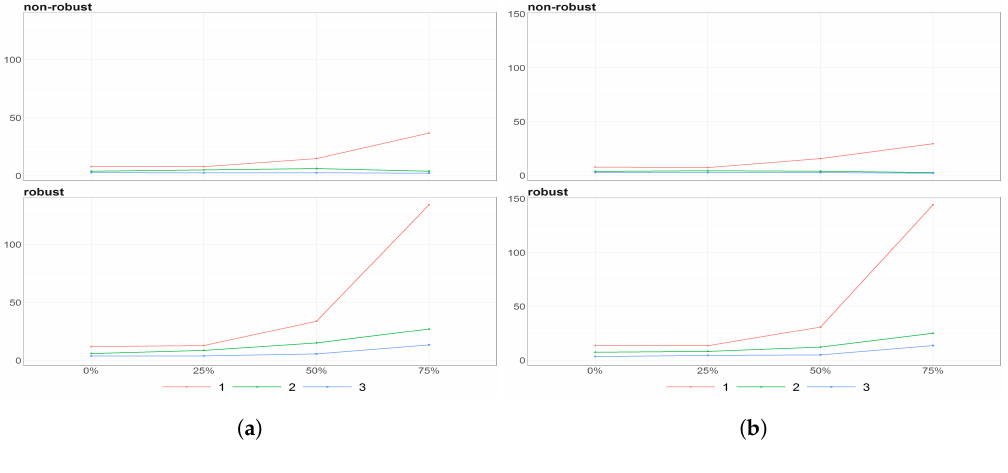
Figure 12. The eigenvalues obtained using PPCA for Females ( a ) and Males ( b ) of Life Expectancy at Birth data for different percentages of maximal missing entries in rows (x axis). Colours of lines corresponds to different eigenvalues, first (light brown), second (dark blue) and third (dark brown) highest. Every subfigure is divided into two subplots corresponding to robust estimation of standard divinations (upper plot) and sample one (bottom